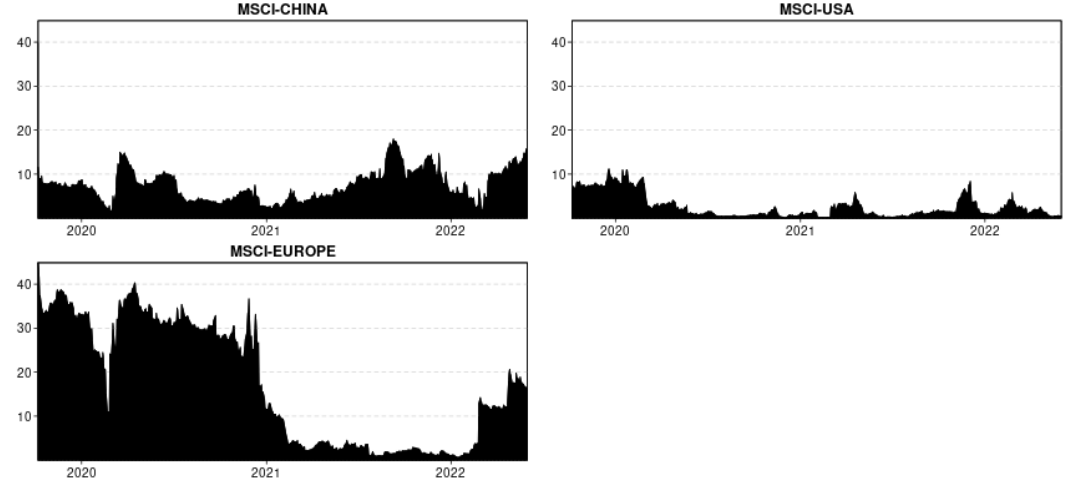
Figure 5. Directional volatility spillovers from others.